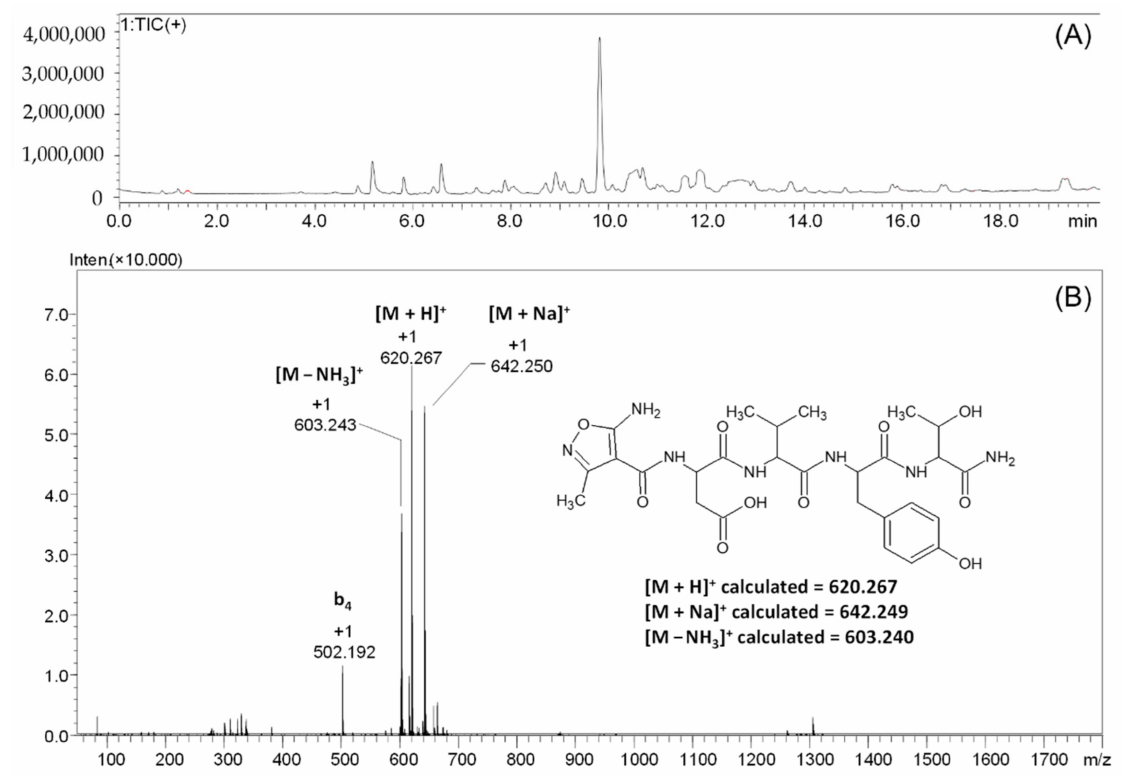
Figure 2. LC-MS analysis of crude product 1 . Total ion current ( A ) and mass spectrum ( B ) of the signal characterized by the retention time of 9.82 min.